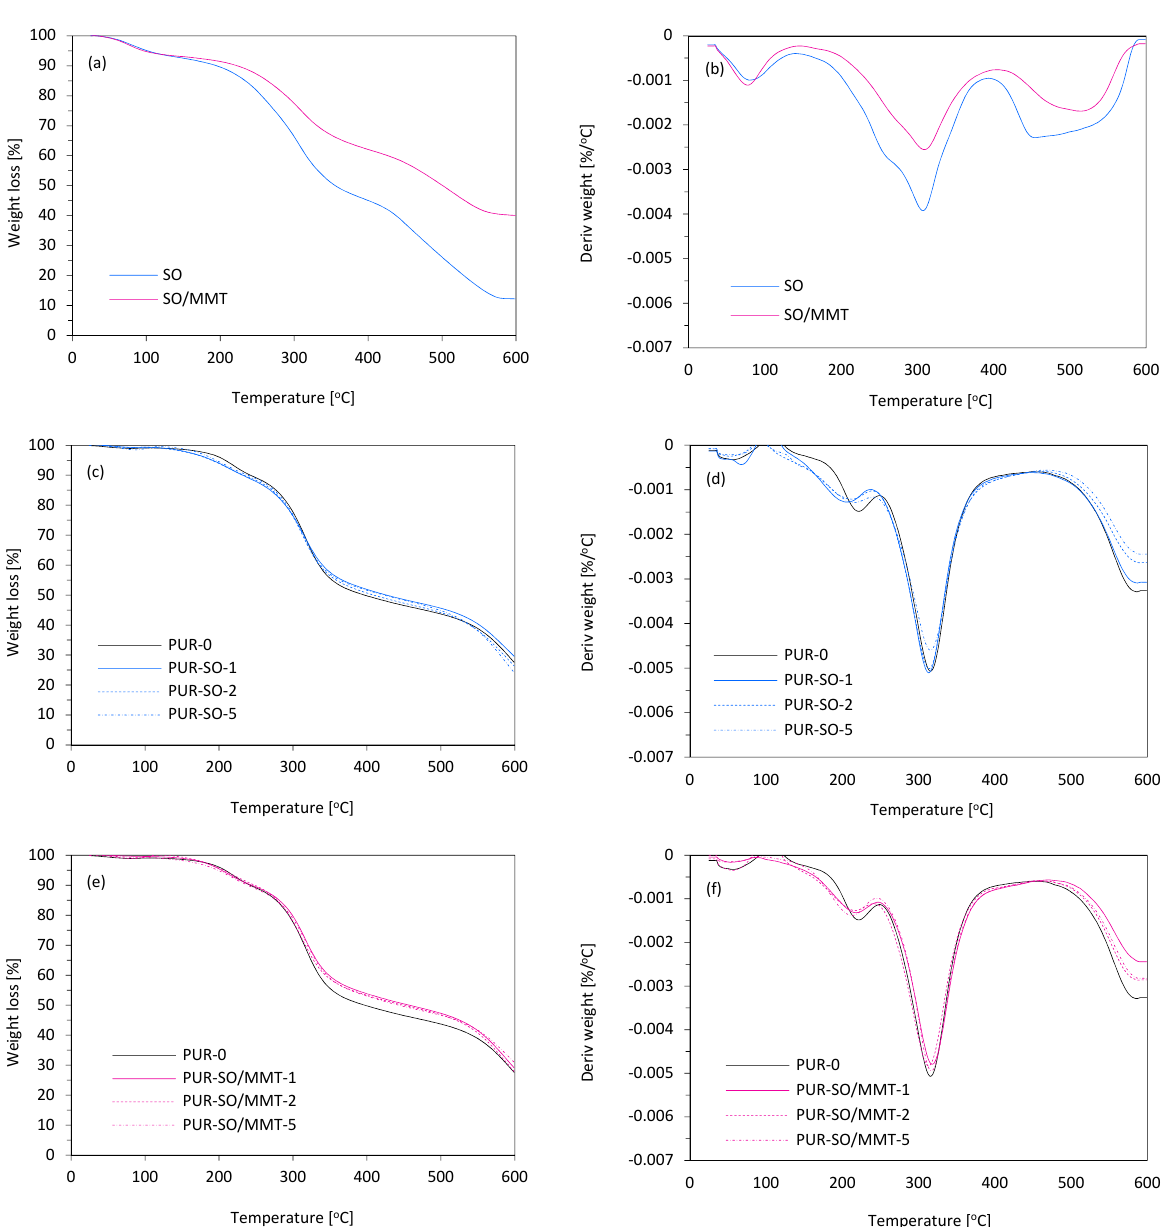
Figure 12. Thermogravimetric analysis of ( a , b ) unmodified and MMT-modified SO filler, ( c , d ) PUR composites reinforced with unmodified SO filler, and ( e , f ) PUR composites reinforced with MMT-modified SO filler.